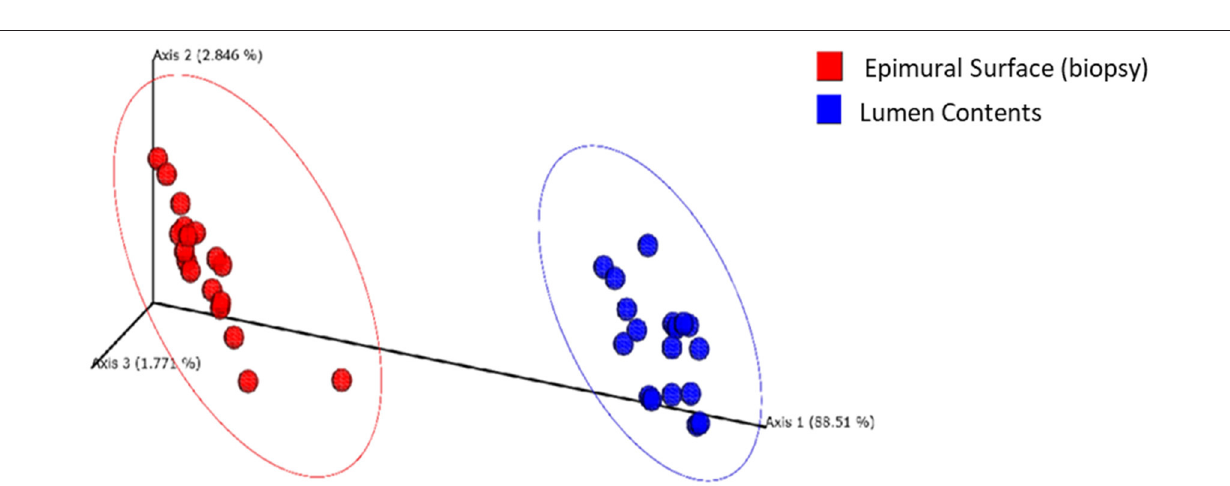
FIGURE 10 | Principal coordinate plot of weighted UniFrac